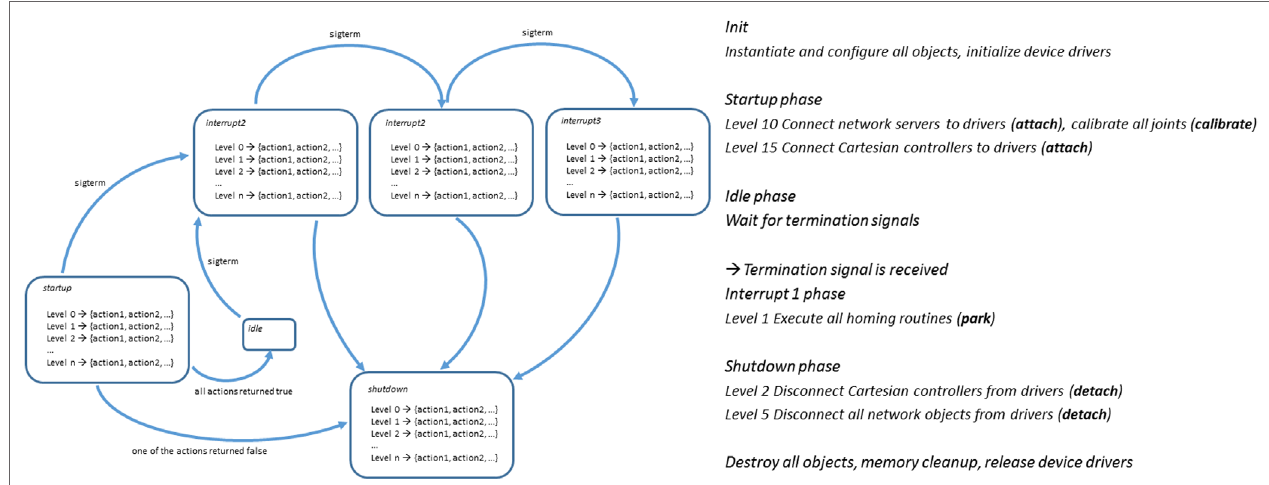
FigUre 6 | state machine of robotinterface . Left: We defined a set of phases that are executed upon activation of certain events, namely: startup , interrupt1 , interrupt2 , interrupt3 , and shutdown . Each phase is further separated in a set of numbered levels each linked to a specific set of actions to be executed. When entering a given phase robotinterface executes all the actions that correspond to the levels that have been configured. Actions at the same levels are executed in parallel in different threads; execution waits for the termination of all threads before proceeding to the next level. In the configuration files, each object can specify one or more actions to be executed, when to execute them (i.e., the phase ) and in which order (the level ). The startup and shutdown phases are executed, respectively, at the beginning and before robotinterface terminates execution. The phases interrupt1, interrupt2, interrupt3 are entered upon subsequent reception of the termination signal (in Linux it is the SIGTERM signal) and are followed by the shutdown phase. During startup robotinterface configures the devices. All network stub objects and controllers register an action called attach specifying the device they will use to perform their tasks. This is usually done at level 1, i.e., just after all devices have been created. They also register the action detach in the phase shutdown (level 5, i.e., after the robot is parked). The calibrators objects register actions calibrate in the startup phase. This is done at level 10, after all attach are executed. Calibrators also register the action park corresponding to phase interrupt1 (level 1) so that the robot is brought to the homing position upon reception of the first termination signal. The calibrators also support an abort action that is executed to abruptly stop any on-going parking or calibration routines after the third termination signal is received. This action is registered for execution at level 1 in the interrupt3 phase. The objects that perform Cartesian control are instantiated during the startup phase and execute attach to get an instance to the joint-level controllers. Proper operation of the Cartesian controllers requires that calibration is performed and that all network objects are instantiated; the attach action for these objects is therefore scheduled at level 15. Symmetrically, their disconnection (i.e., detach action) is scheduled early on during shutdown , i.e., at level 2. Right: Main steps of execution of a typical run of the